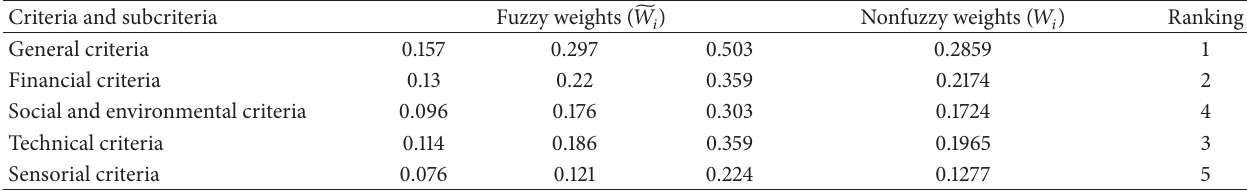
Table 9: Fuzzy and crisp weights and ranking scores for criteria in the main level.